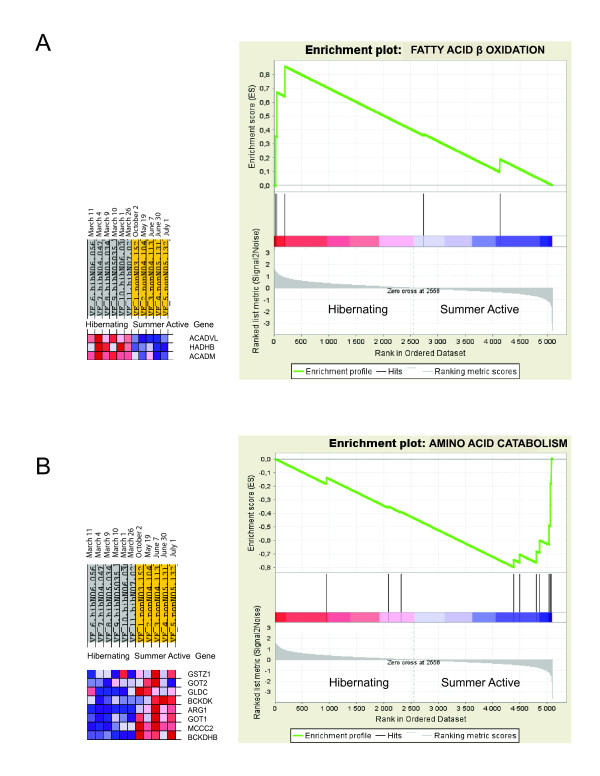
Gene set enrichment analysis results for the fatty acid β oxidation and amino acid catabolism categories. The fatty acid β oxidation category (A) is enriched by up regulated genes (FDR = 0.043) and amino acid catabolism (B) is enriched by down regulated genes (FDR = 0.015) in liver of hibernating black bears. The figure legend is explained in the text of Figure 2.